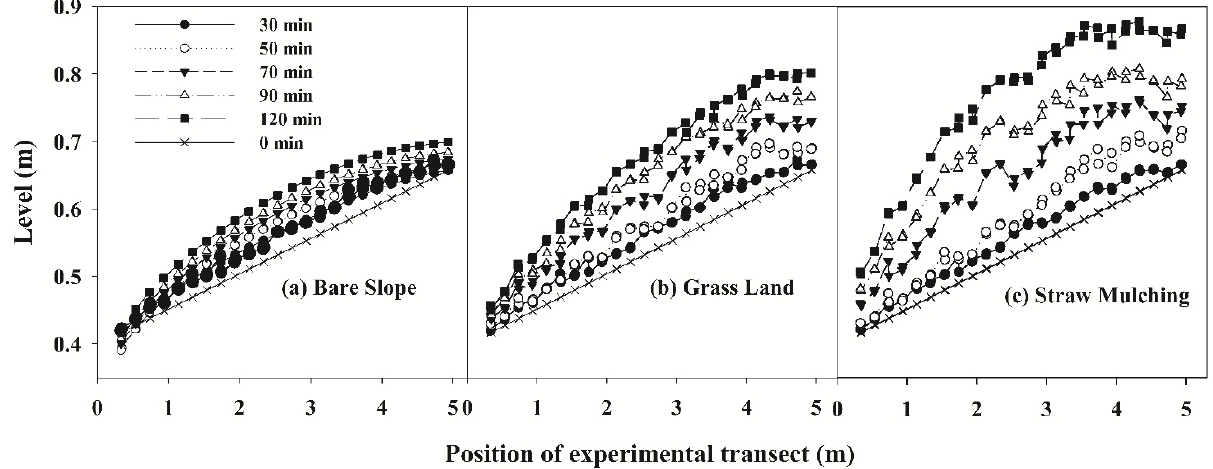
Figure 12. Comparison of the magnitude of the groundwater level fluctuations arisen from land cover variations (t = 0–120 min).